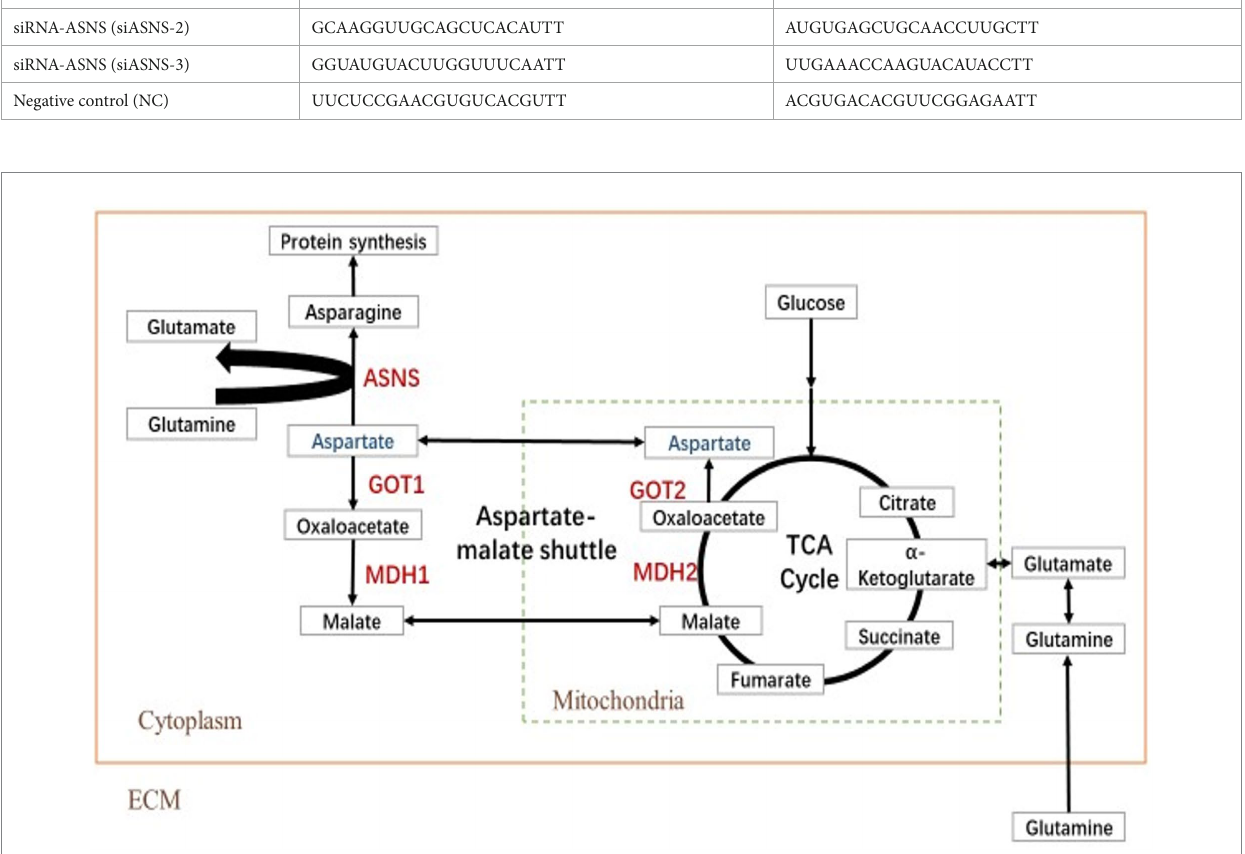
FIGURE 1 Simplified schematic of aspartate metabolism. Reactions within the box are intracellular, and inside the dotted box occurs in the mitochondrion (Mito), whereas those outside in the dotted box occur in the cytoplasm (Cyto). TCA cycle, tricarboxylic acid cycle; MDH, malate dehydrogenase; GOT, glutamic oxalacetate transaminase; and ASNS, asparagine